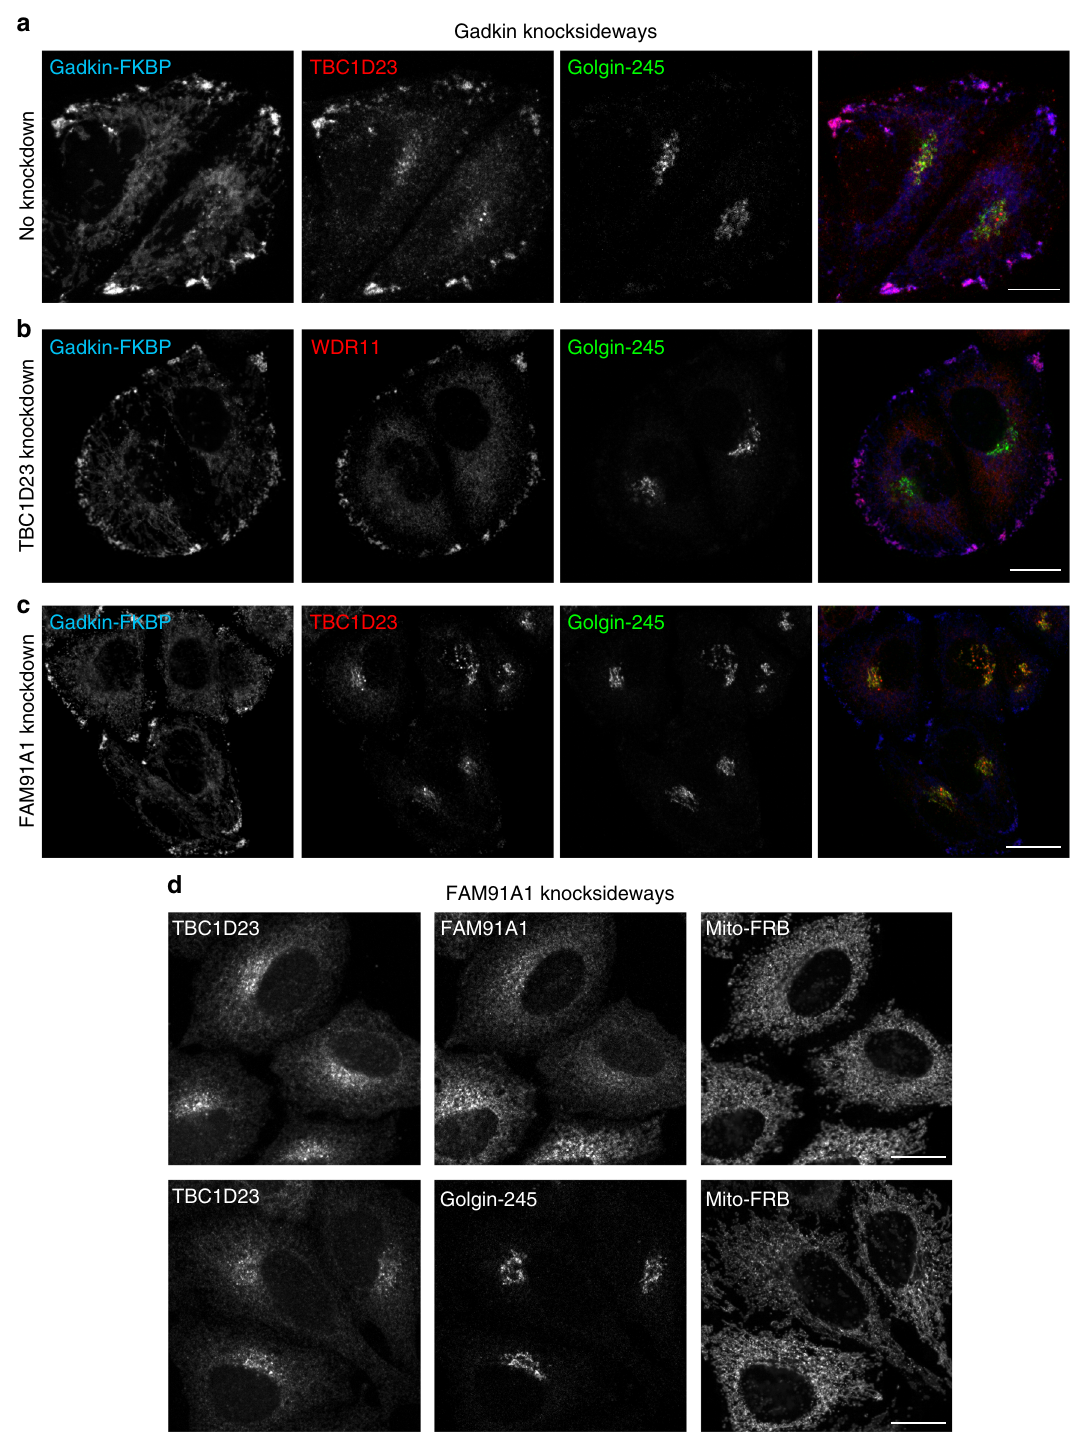
Fig. 8 Recruitment of TBC1D23 by the WDR11 complex. a Gadkin knocksideways cells were treated as in Fig. 7d and then labelled for gadkin-FKBP, TBC1D23 and golgin-245. Like WDR11, much of the TBC1D23 is relocated to the cell periphery. b Knocking down TBC1D23 does not affect the ability of the WDR11 complex to be redistributed in gadkin knocksideways cells. c In contrast, knocking down FAM91A1 prevents TBC1D23 from being redistributed in gadkin knocksideways cells, causing it to remain colocalised with golgin-245. d FAM91A1 knocksideways causes TBC1D23 to be relocated to mitochondria, while the localisation of golgin-245 does not change. Scale bars: 20 µ m. Representative confocal images are shown from three independent